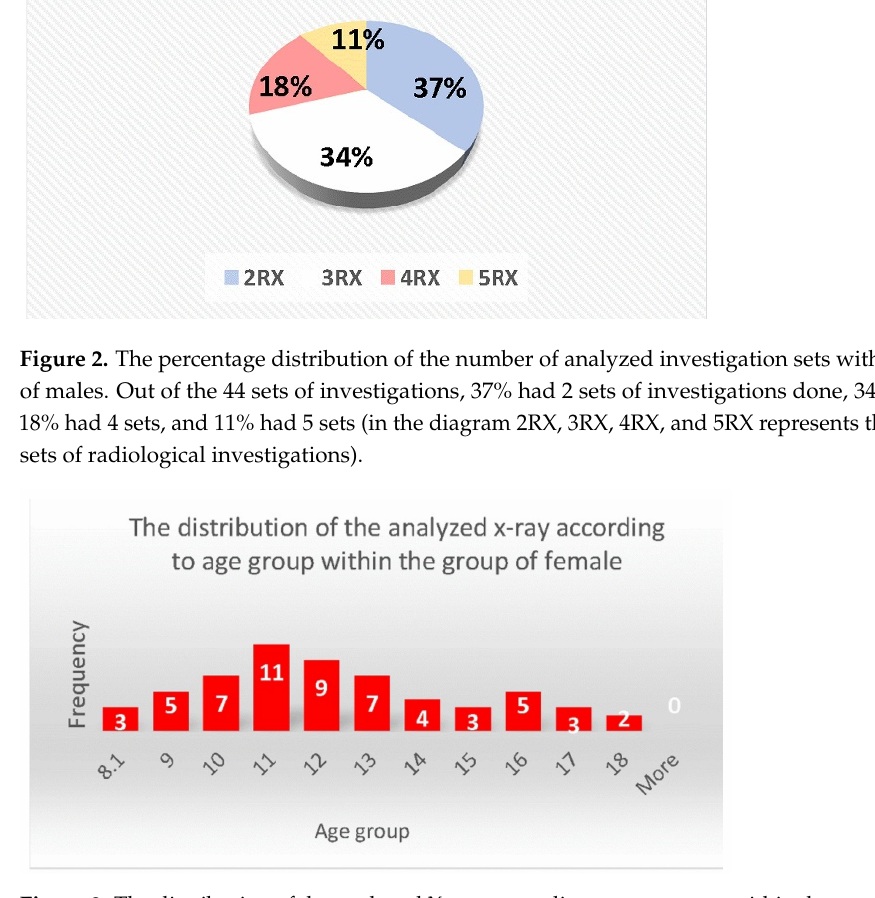
Figure 3. The distribution of the analyzed X ‐ rays according to age groups within the group of fe ‐ males.